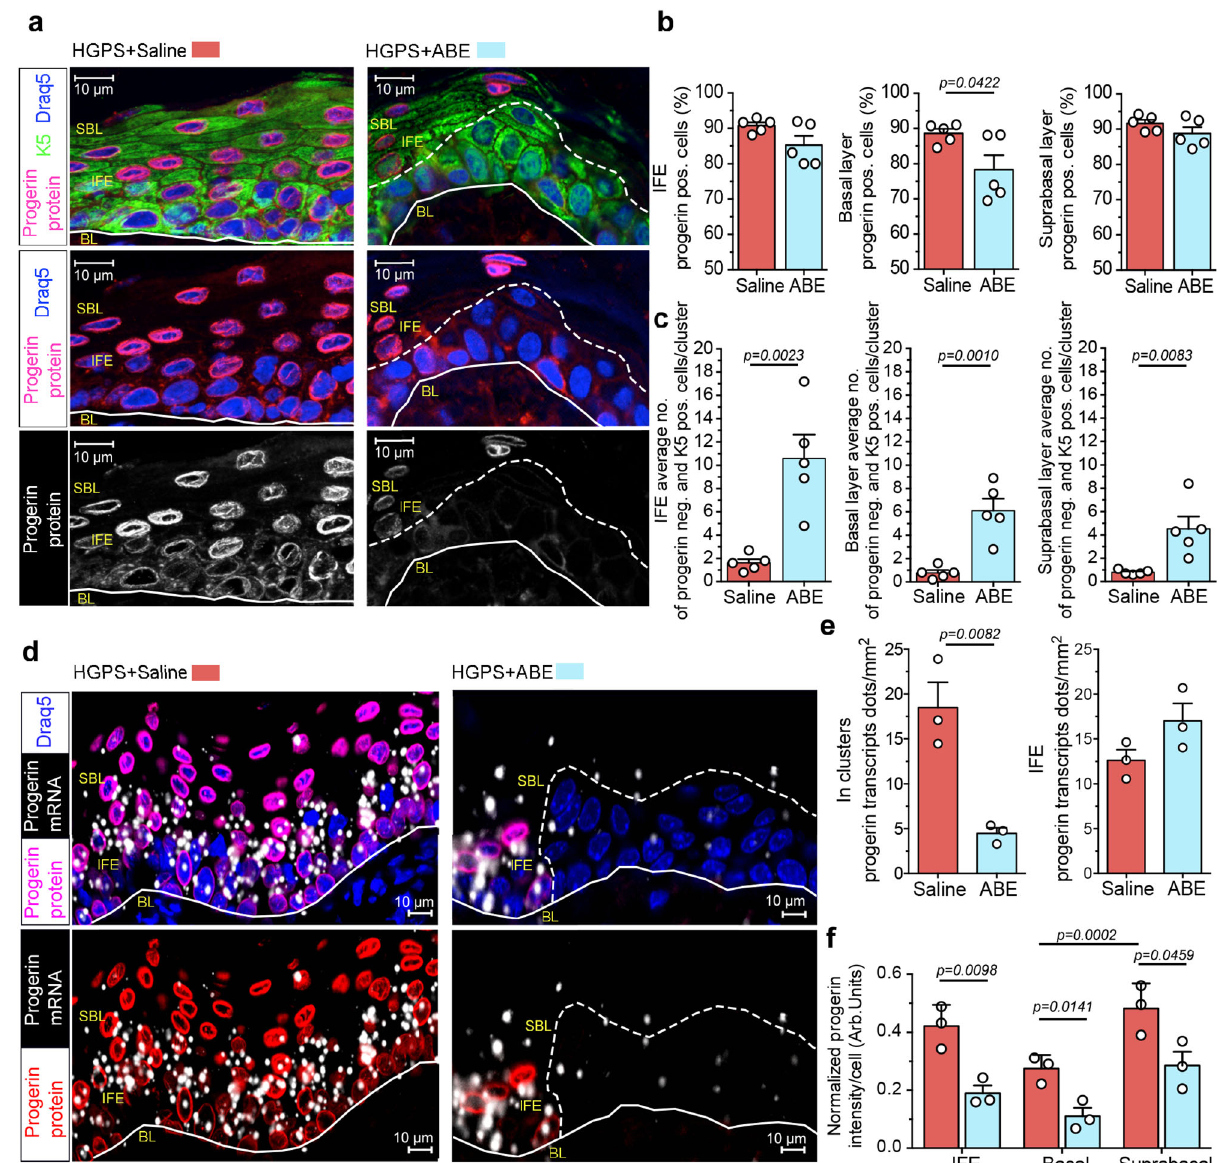
Fig. 4 LF-ABE treatment of HGPS mouse skin reduces the amount of progerin-expressing cells in the basal progenitor layer of the skin. a Progerin and keratin-5 (K5) immuno fl uorescence staining of LF-ABE and saline-treated HGPS skin collected four weeks after treatment. b Quanti fi cation of the frequency of progerin protein expressing cells in the IFE, and speci fi cally in the basal (Saline compared to ABE, p = 0.0422) and suprabasal layers of LF-ABE ( n = 5 biologically independent samples) and saline-treated ( n = 5 biologically independent samples) HGPS skin. c The number of progerin negative per keratin-5 positive cells/cluster in the IFE (Saline compared ABE, p = 0.0023), and speci fi cally in the basal (Saline compared ABE, p = 0.0010) and suprabasal layers (Saline compared ABE, p = 0.0083) of LF-ABE ( n = 5 biologically independent samples) and saline-treated ( n = 5 biologically independent samples) HGPS skin is shown. d , e Progerin transcript levels measured by progerin in situ hybridization ( d ) in the IFE and in clusters (Saline compared to ABE, p = 0.0082) of progerin negative cells ( e ) in LF-ABE treated skin ( n = 3 biologically independent samples) in comparison to saline-treated HGPS skin ( n = 3 biologically independent samples). f Decreased progerin accumulation in the IFE ( p = 0.0098) and in the basal ( p = 0.00141) and suprabasal skin layers ( p = 0.00459) four weeks after LF-ABE ( n = 3 biologically independent samples) treatment in comparison to saline-treated HGPS skin ( n = 3 biologically independent samples) measured by progerin intensity normalized to DAPI intensity (Arbitrary Units = Arb. Units) Signi fi cant progerin accumulation ( p = 0.002) between the basal ( n = 3 biologically independent samples) and suprabasal skin layer ( n = 3 biologically independent samples) of saline-treated HGPS mice. BL = basal skin layer, the fi rst cell layer on top of the white line; cluster of progerin negative cells are delineated with a dotted white line, SBL = suprabasal skin layer, IFE = interfollicular epidermis. Scale bars: a, d = 10 μ m. Saline-treated samples are depicted in red, LF-ABE treated samples are depicted in blue. Data are represented as mean values + / − SEM. b , c , e , f P values between samples were calculated by two-tailed unpaired t test, 95% CI. f P value between groups was calculated by one-way ANOVA, adjusted for multiple comparisons, 95% CI. For ( b , c , e , f ) data are provided as a Source Data fi